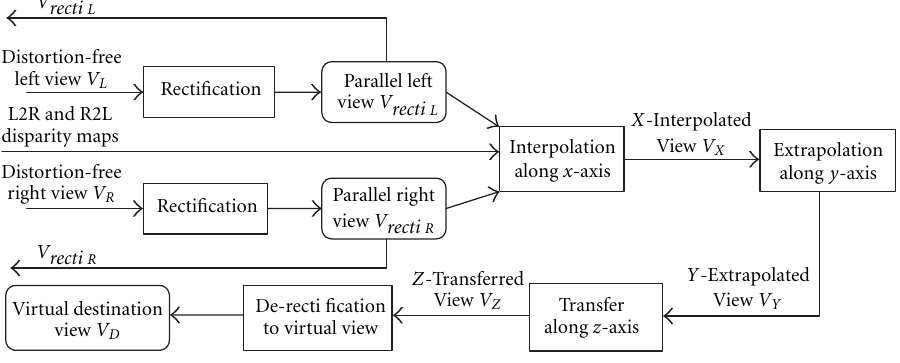
Figure 4: The multi-step view synthesis framework for VIRTUE. Multiple separate steps work together to eliminate three major di ff erences between the final novel view V D and the two original views V L and V R : (1) photometric di ff erences such as focal length and aspect ratio etc.; (2) position in 3D space ( x, y,z ); (3)